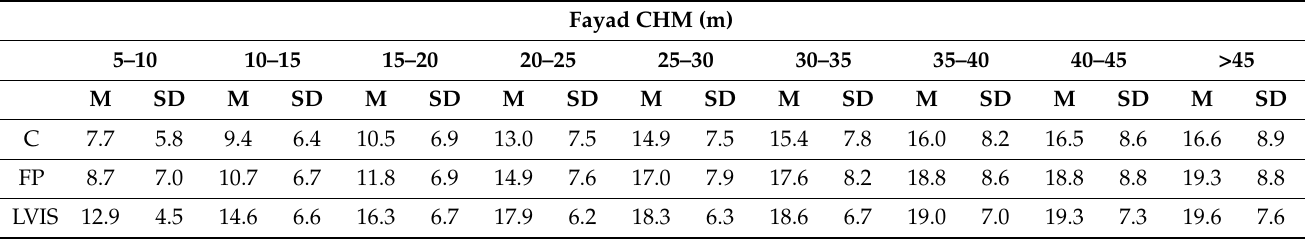
Table A2. Mean (M) and standard deviation (SD) of the elevation difference between EHR and SRTM. (C) and (FP) correspond to the EHR values from GEDI’s coverage and full-power lasers, respectively. (LVIS) corresponds to the EHR values from LVIS.